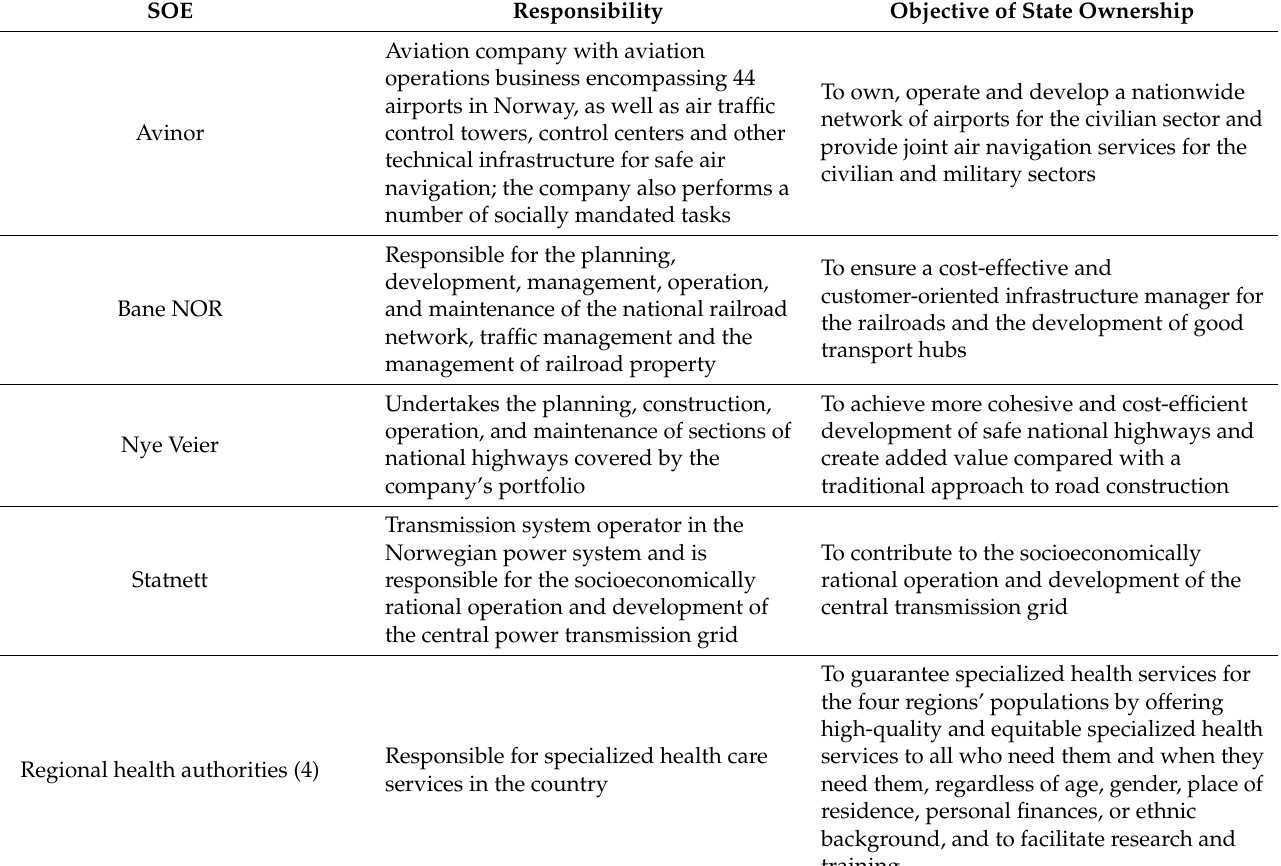
Table 2. Overview of the studied SOEs.